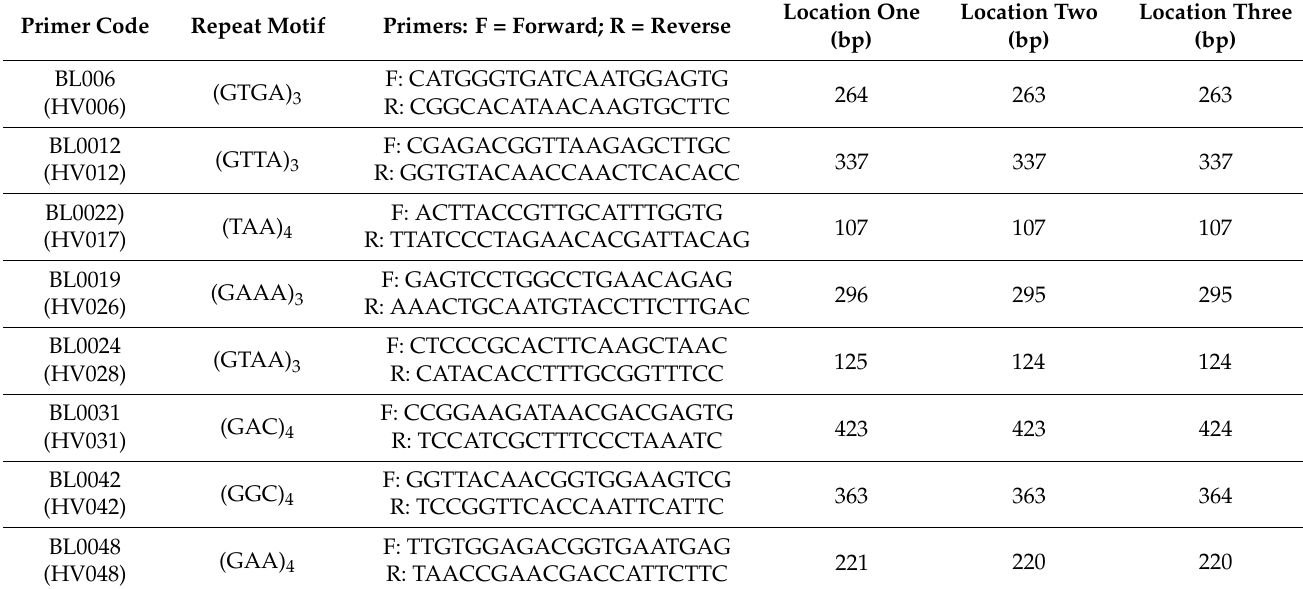
Table 1. Primer codes, repeat motifs and primer sequences of simple sequence repeats (SSRs) used to determined clonality of Helianthus verticillatus plants at three locations in Knoxville, Tennessee, USA.